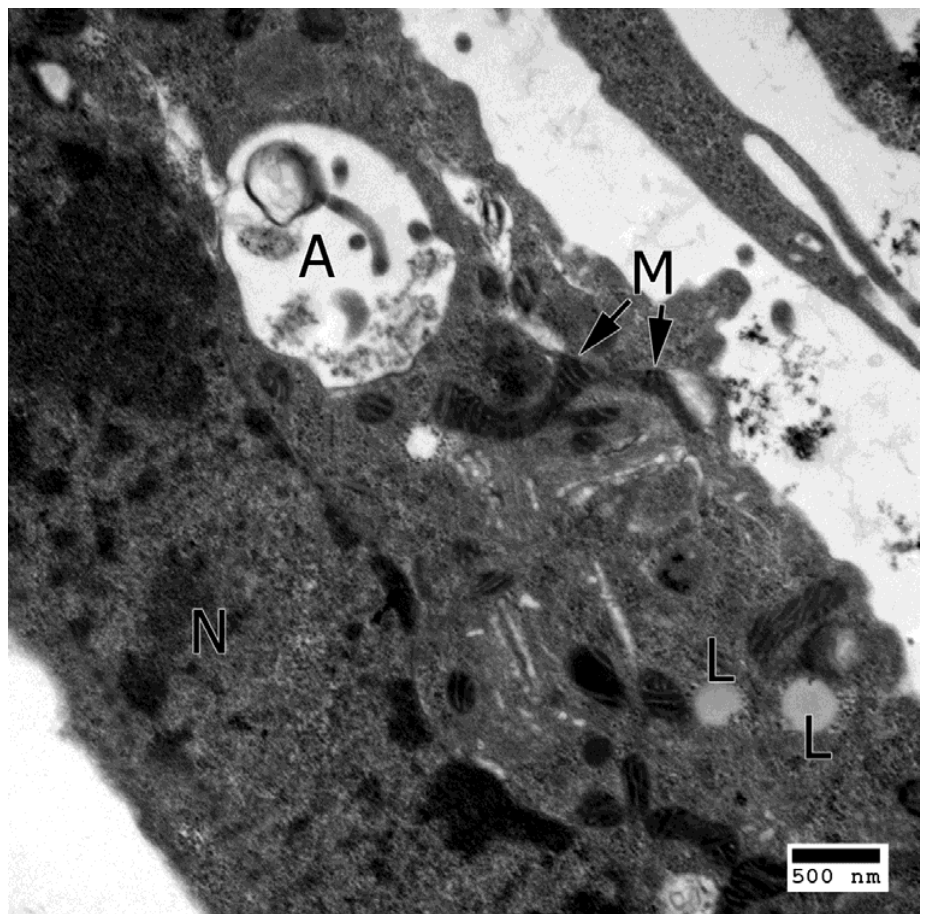
Figure 2. Electron micrograph showing the effects of in vitro application of IL-17 to ARPE-19 cells. IL-17 induced mitochondrial (M) damage as well as autophagosome (A) formation. Nuclear membrane appears compromised (N), chromatin is diffused and heterochromatin distributed along the nuclear membrane. Lipid droplets (L) are observed in the